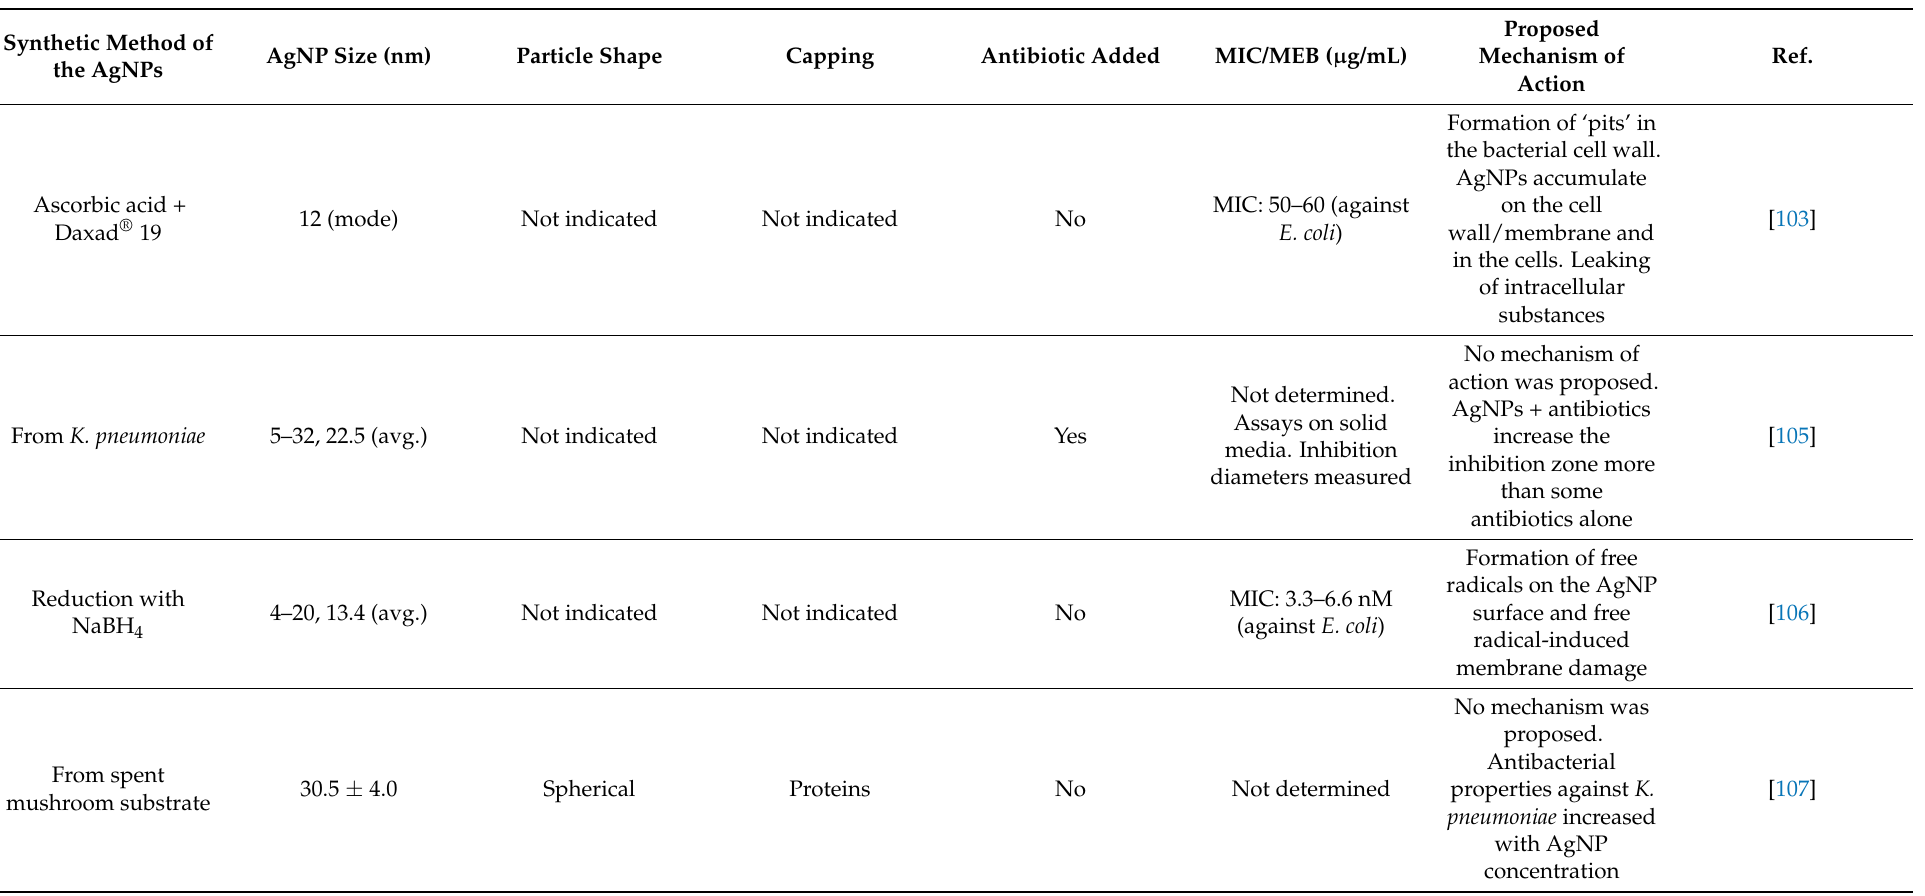
Table 3. Research on the activity of AgNPs against Enterobacteriaceae in vitro